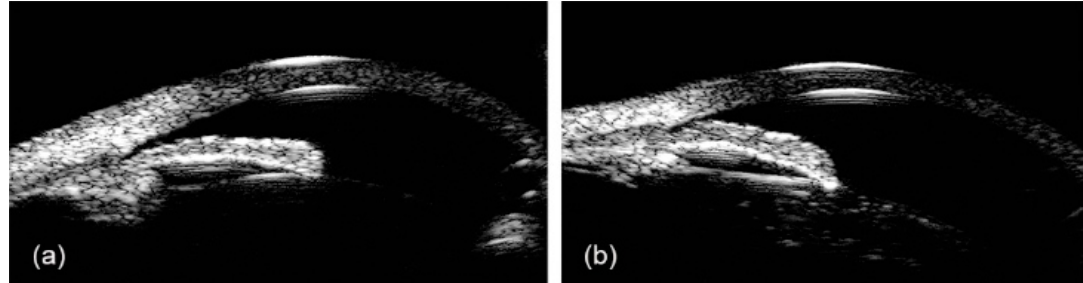
Figure 3. Ultrasound biomicroscopy images of narrow angle ( a ) and plateau iris configuration ( b ).